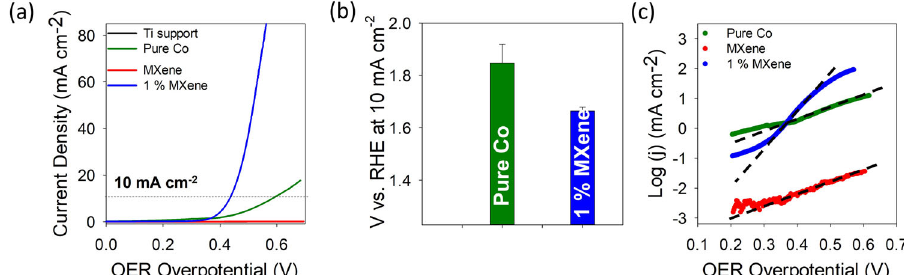
Fig. 3 Initial oxygen evolution studies. a Linear sweep voltammetry curves at a scan rate of 1 mV dec − 1 at a rotation speed of 1600 rpm for the Ti support, pure Co, 1% MXene and the pure MXene materials. b Bar chart showing the potential (V vs. RHE) need to reach a current density of 10 mA cm − 2 for the pure Co and 1% MXene. Standard deviations calculated from three different freshly prepared electrodes for each material. c Tafel plots for the pure Co, 1% MXene and the pure MXene materials. Dash lines indicate slope for each